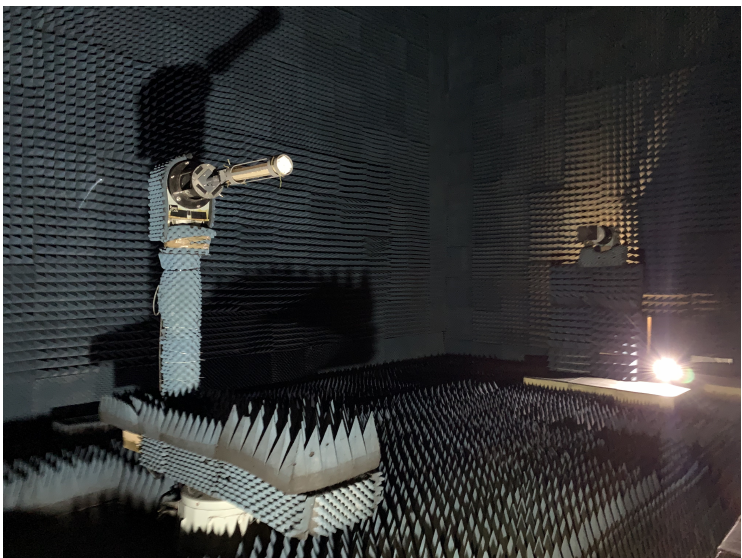
Figure 14. NADS FM in the UPC Antenna Lab Anechoic